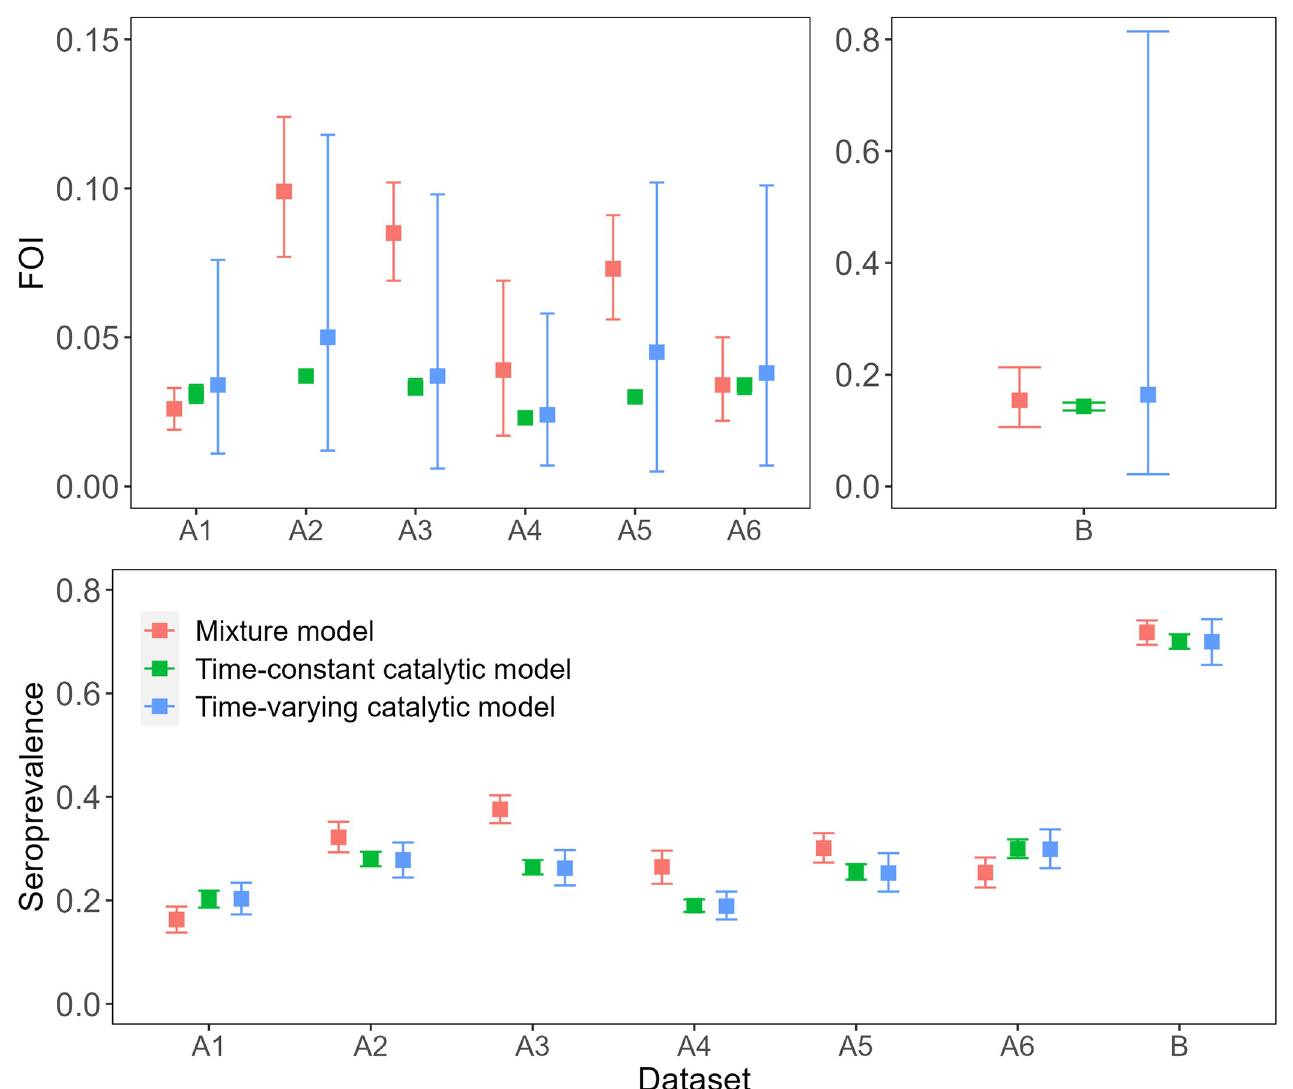
Fig 4. Force of infection (FOI) and total population level seroprevalence (SP) estimates from the mixture model and the catalytic models fitted to the observed data. The catalytic model was run under the time-constant and time-varying FOI assumption. The 95% Confidence Intervals (CI) which were calculated by bootstrapping for all models are given as error bars. Note that the y-axis limits differ for each panel.